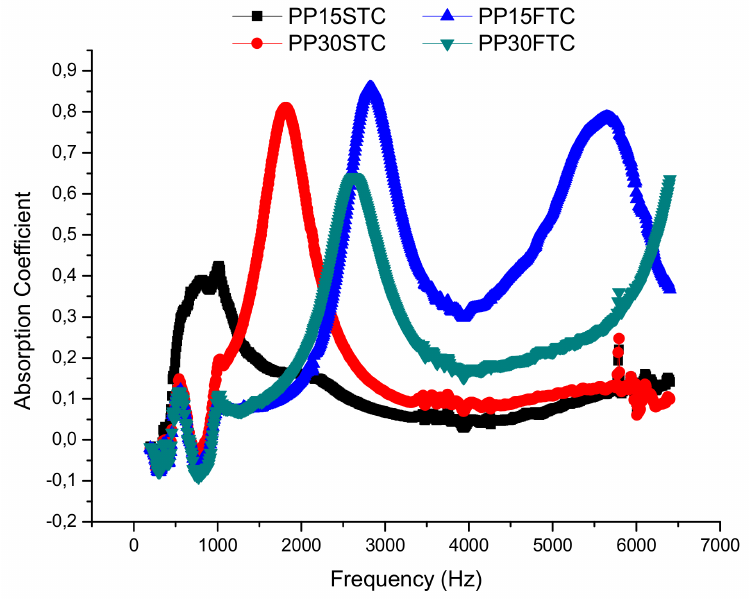
Figure 8. The Absorption performances of Placuna placenta composite with Side and Front Tailed